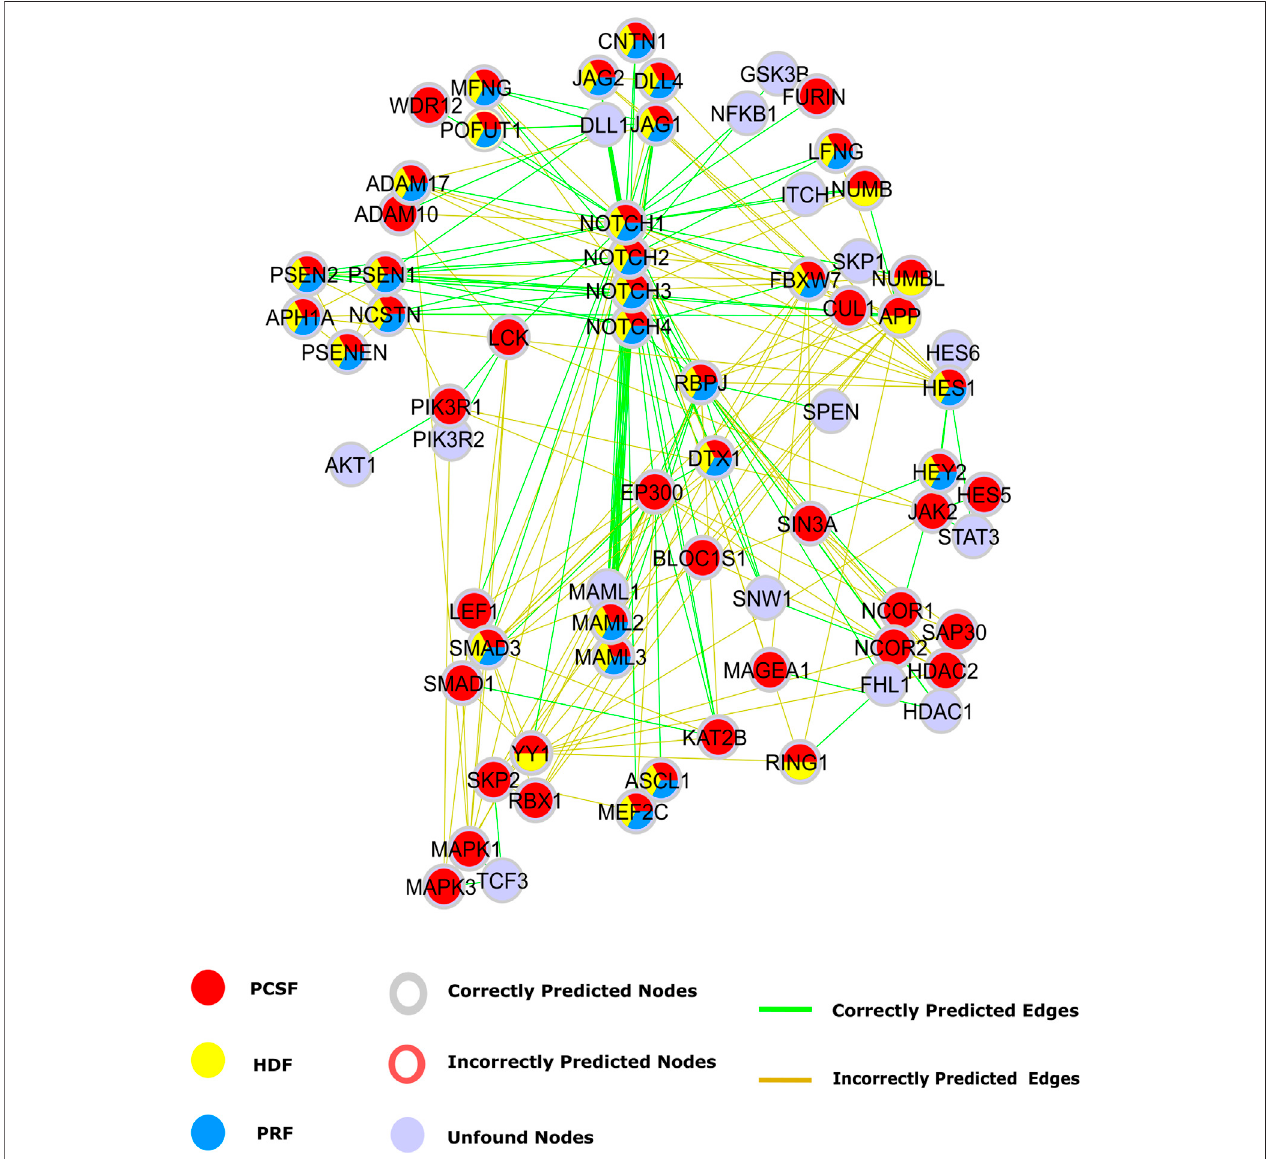
FIGURE7| ReconstructedNotchpathway.Nodesthatarepresentinthepathway,butarenotfoundbyanyalgorithmsarecoloredlightblue.Nodesthatarefound by PCSF, PRF, and HDF are colored red, yellow, and cyan, respectively. Green edges are present in Notch pathway in NetPath, while incorrectly included edges by any algorithm are shown in